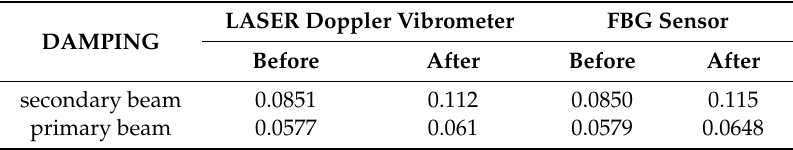
Table 2. Mean damping values estimated by the two measurement